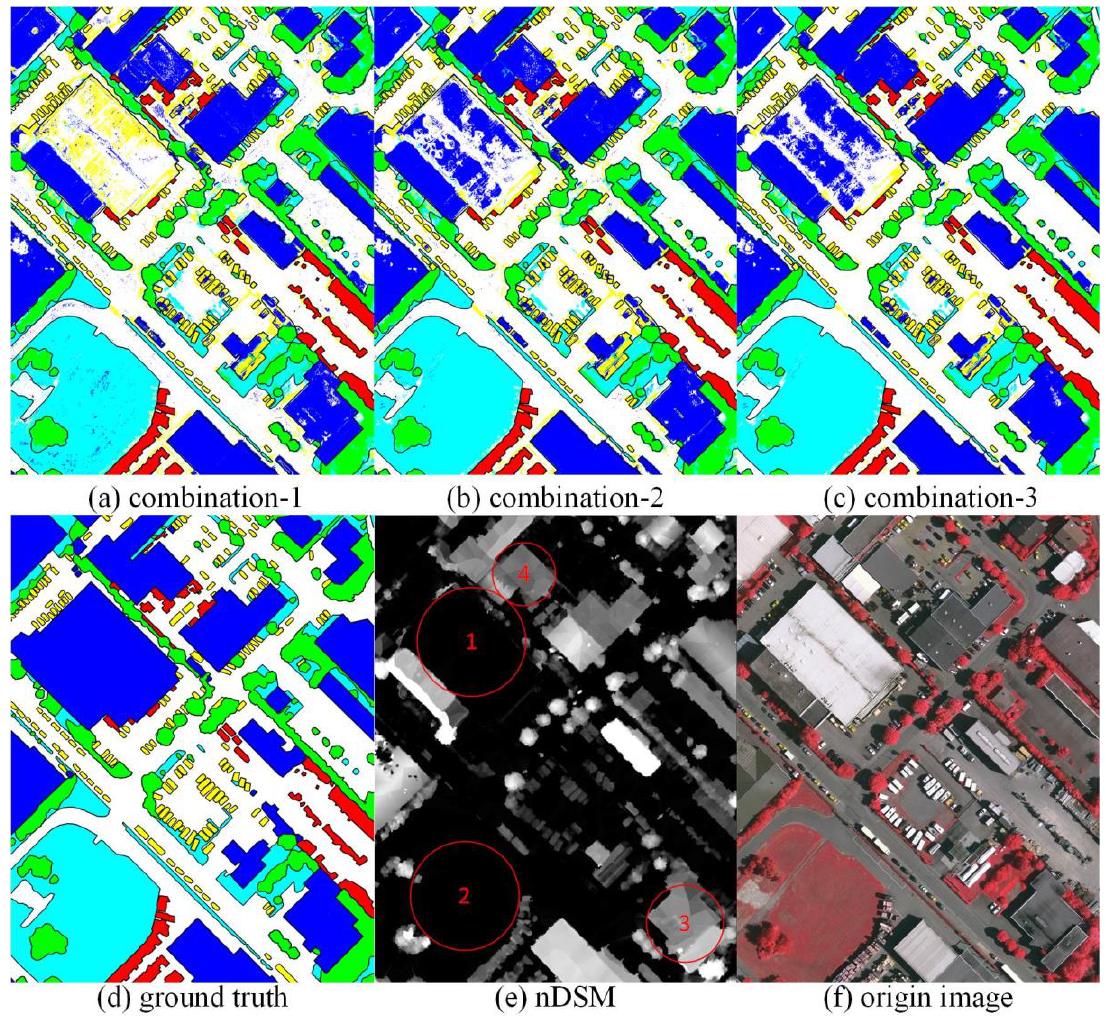
Figure 1. Classification results of ‘area-31’. (a)(b)(c) are classification result of three combination of features; (d) is ground truth; (e) is nDSM; (f) is origin image with three RGB bands corresponding to the near infrared, red and green